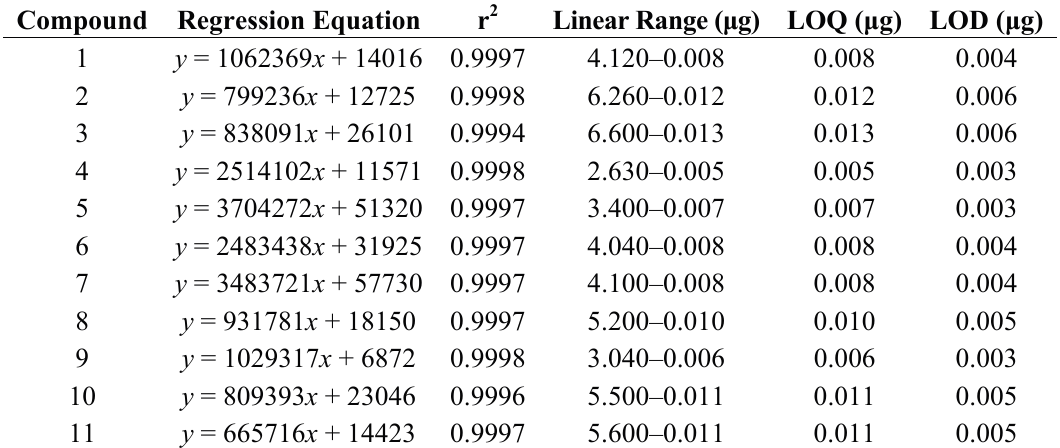
Table 2. Calibration data for the alkaloids of Corydalis Rhizoma.